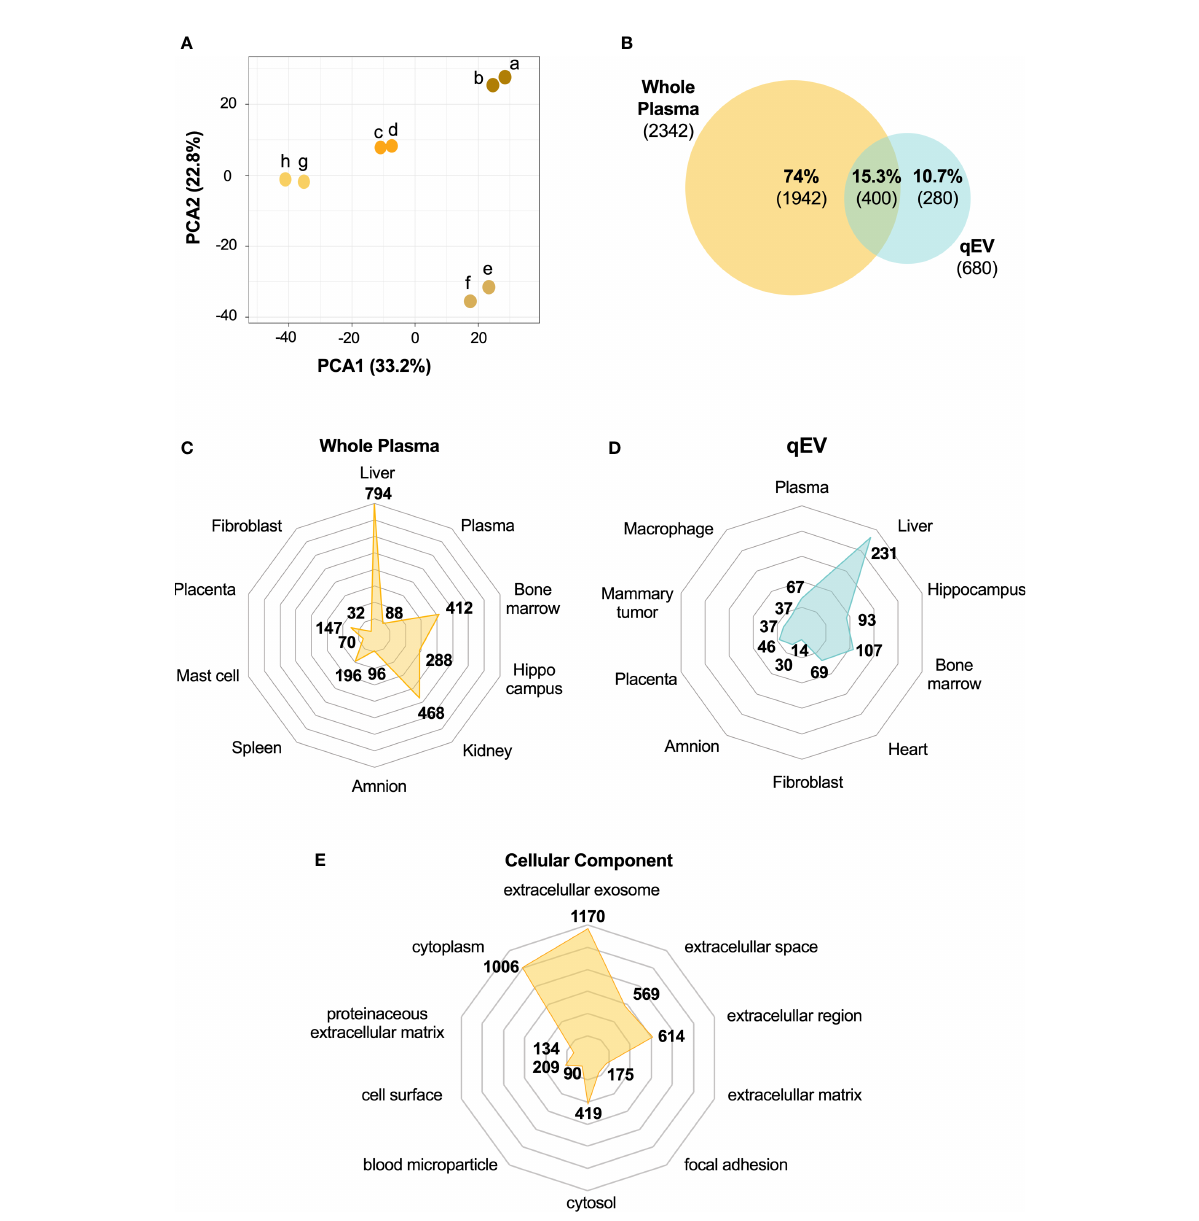
FIGURE 4 The whole plasma proteome differs from the plasma-derived EV proteome. Plasma was collected from non-diabetic NOD mice (n = 4). Abundant plasma proteins were removed using an af fi nity column. Samples (two technical replicates of each) were then subjected to HiRIEF-LC-MS/MS analysis. (A) Principal Component Analysis (PCA) of the proteome of whole plasma samples showing the clustering of the technical replicates (technical replicates are shown in the same color). (B) Venn Diagram of unique and overlapping proteins between whole plasma and qEV proteomes presented as percentages of the total number of proteins identi fi ed and absolute numbers. (C, D) Tissue enrichment analysis of both proteomes showing the top 10 most signi fi cant tissues in whole plasma and qEV samples, respectively. (E) Top 10 enriched GO terms for cellular components of the whole plasma proteome. The numbers in C-E represent the counts in each term and the enriched GO terms were scored according to a p-value